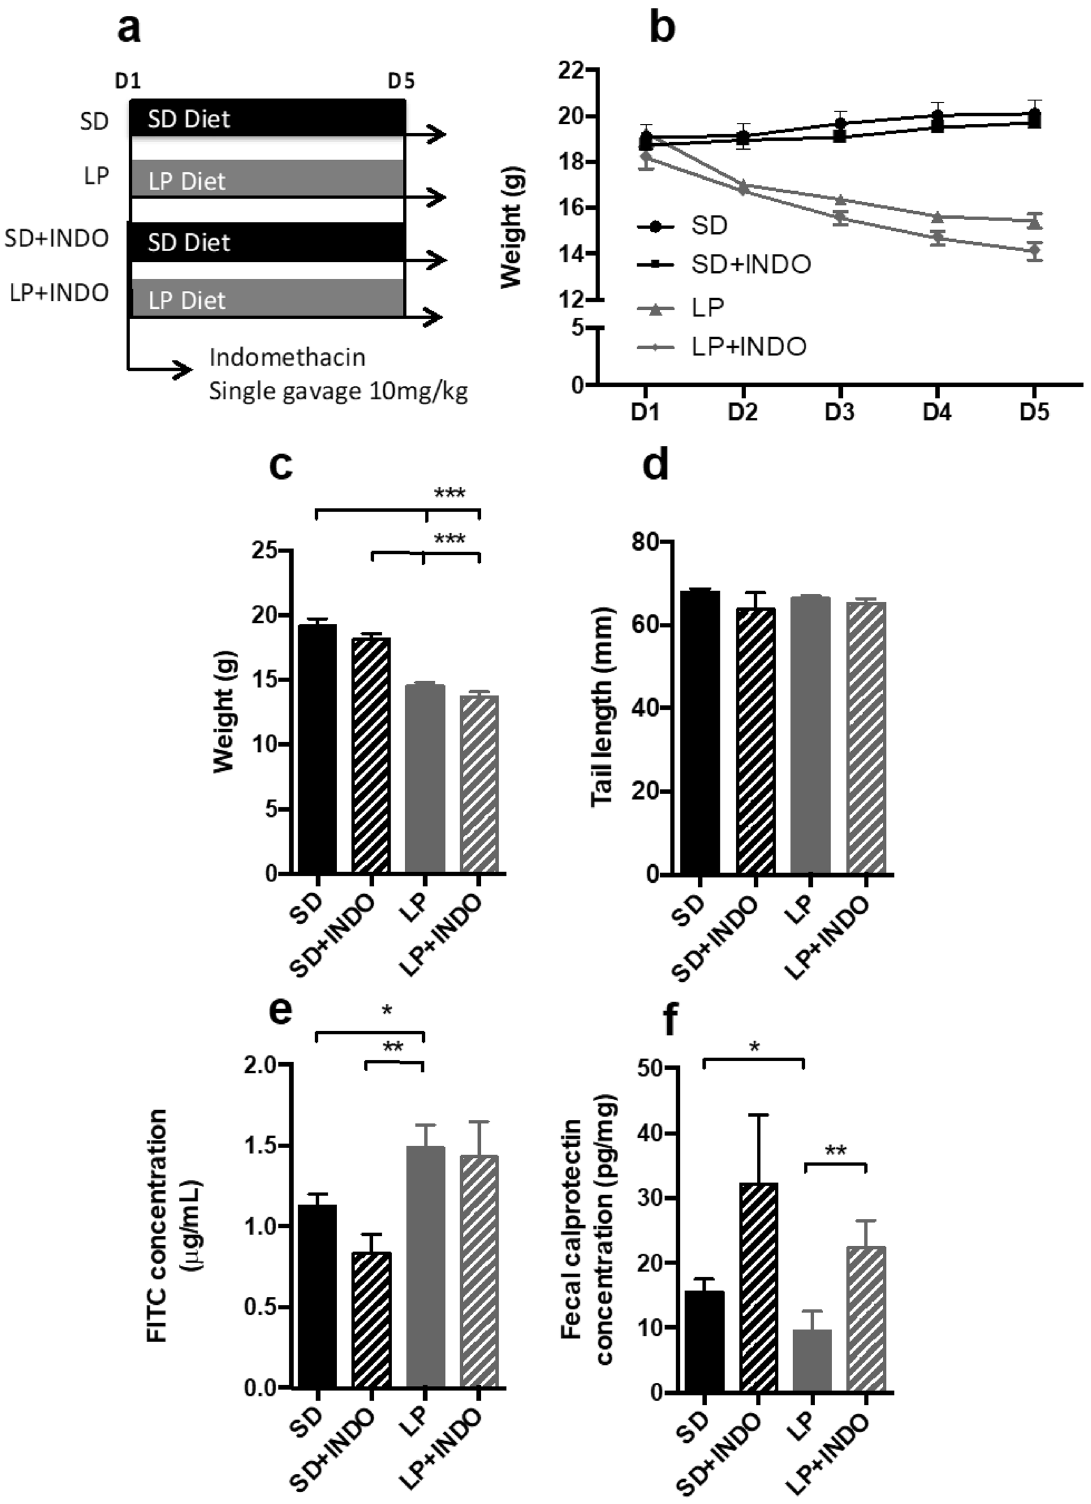
Figure 3. Growth, intestinal inflammation and permeability assessment in C57BL/6 mice fed a low protein combination with a single indomethacin gavage. ( a ) 3-weeks-old mice were fed with standard or low protein diet for 5 days. At day 1, a single gavage of indomethacin (10 mg/kg) was performed. ( b ) Body weight was recorded every day until the end of the experimentation (n = 20 per group). Plots represent the mean ± SEM (***P < 0.0001, Two Way ANOVA). At D5, ( c ) body weight (n = 20 per group) and ( d ) tail length (n = 20 per group) were measured. Bars indicate the mean ± SEM Kruskal–Wallis test with post hoc Dunn’s test was performed (***P < 0.0001). ( e ) Bars indicate the mean ± SEM of the serum FITC concentration (assessed 3 h post per o s administration; n = 20 per group). One-way analysis of variance with post hoc Tukey’s test (**P < 0.0041) and unpaired t-test (*p < 0.05) was performed. ( f ) Bars indicate the concentration of fecal calprotectin in mice at D21 (n = 20 per group). Mann–Whitney test was performed (**p = 0.0011; *p = 0.0037). SD, Standard diet; LP, Low protein diet; LP + INDO, LP + i.p. injection of